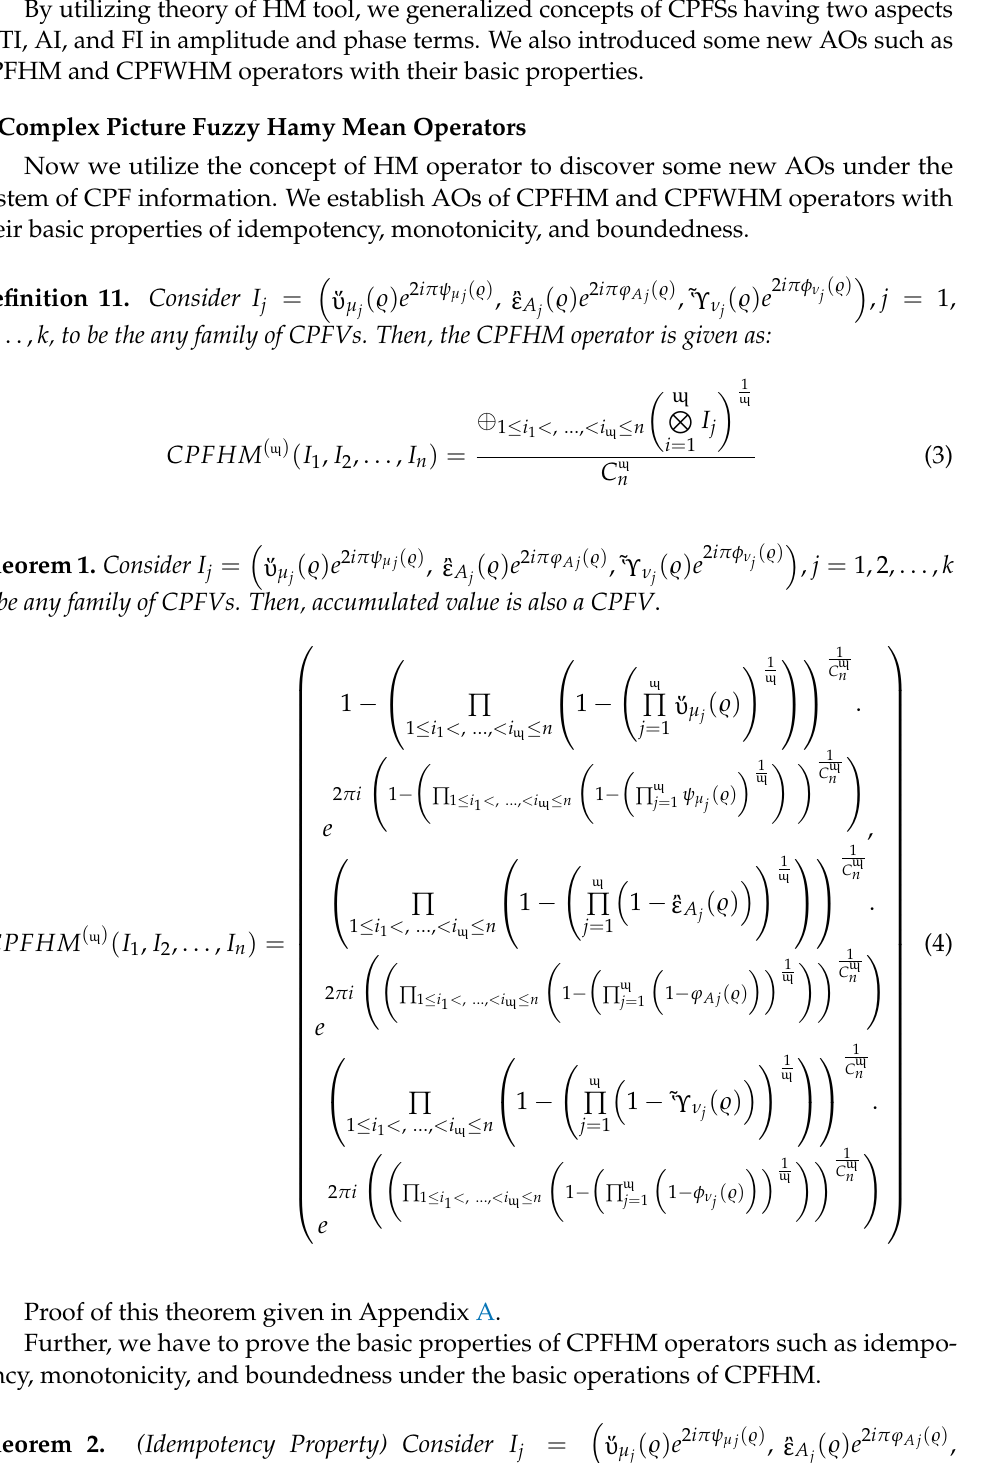
Table 1. Symbols and their meanings.